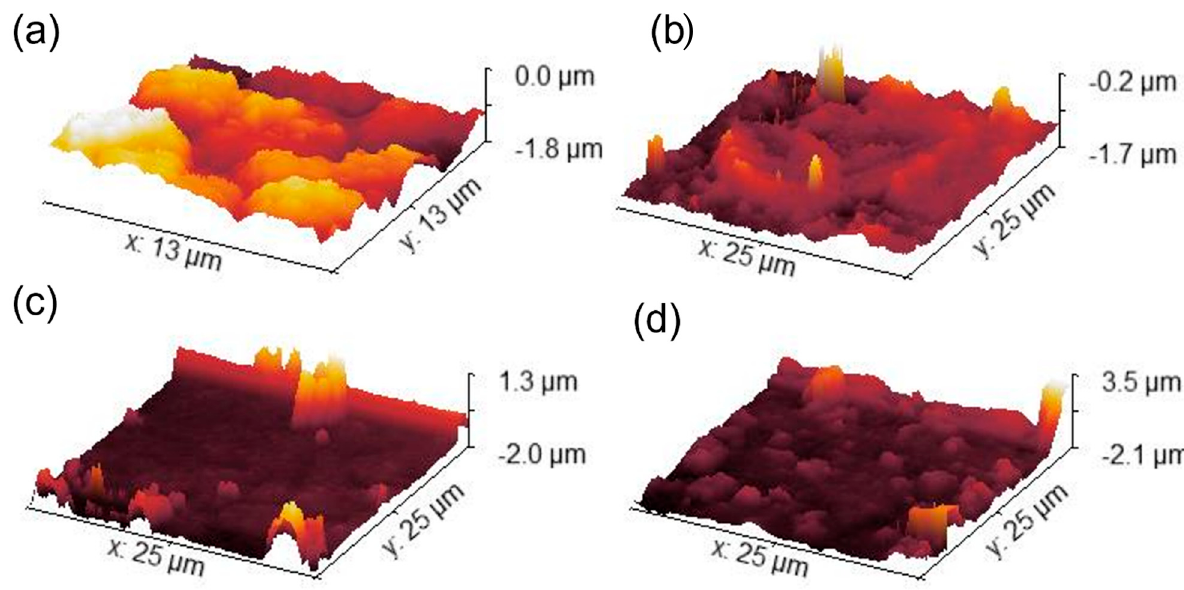
Figure 6. AFM 3D topography images of ( a ) FA 0.8 Cs 0.2 PbI 2.85 Br 0.15 , ( b ) FA 0.8 Cs 0.2 PbI 2.5 Br 0.5 , ( c ) FA 0.8 Cs 0.2 PbI 2.3 Br 0.7 , and ( d ) FA 0.8 Cs 0.2 PbI 2 Br 1 films deposited on FTO-covered glass substrates. The FA 0.8 Cs 0.2 PbI 2.85 Br 0.15 (x = 0.15) sample exhibits an average roughness of 68.7 nm,